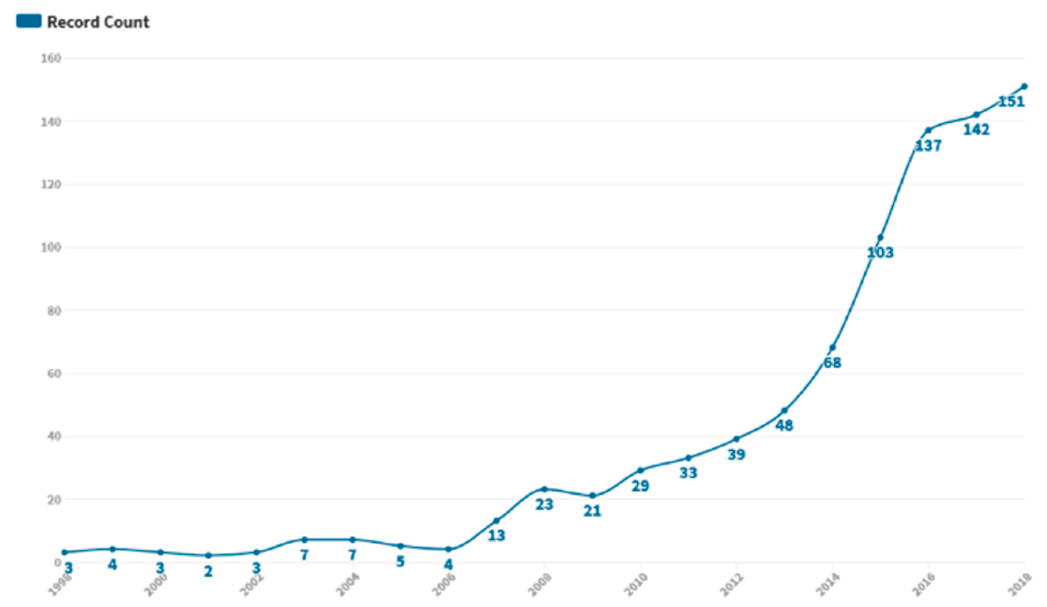
Figure 1. Publication years and record count.